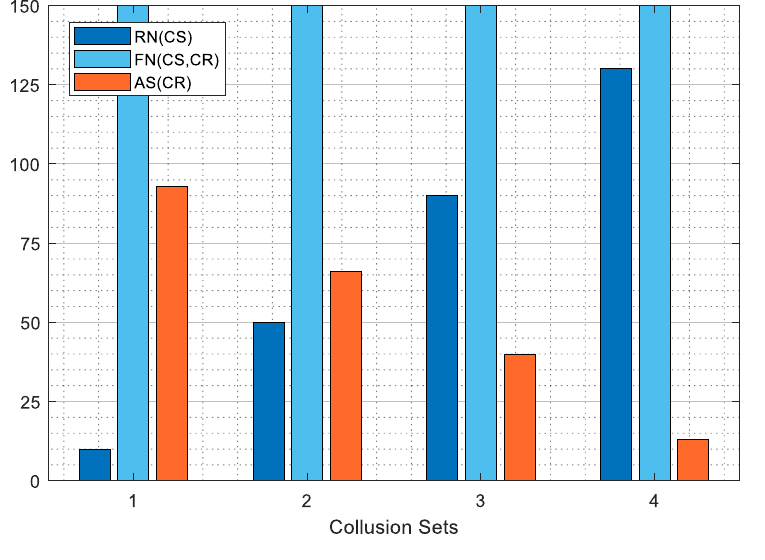
Figure 6. Attack scale (AS) .